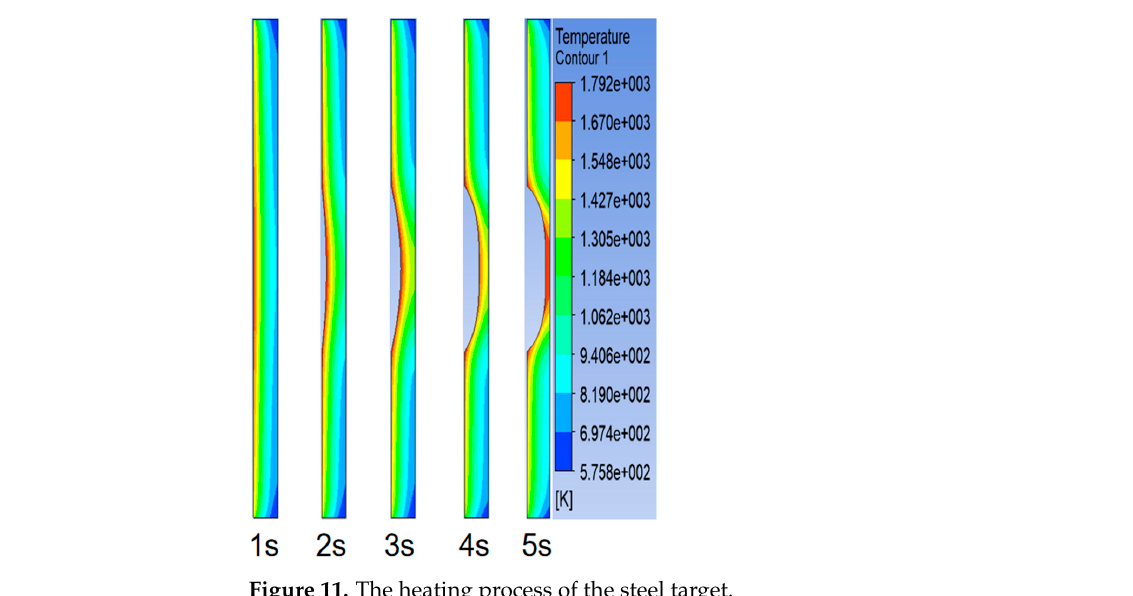
Figure 12. Simulation and test results of the temperature rise curve.